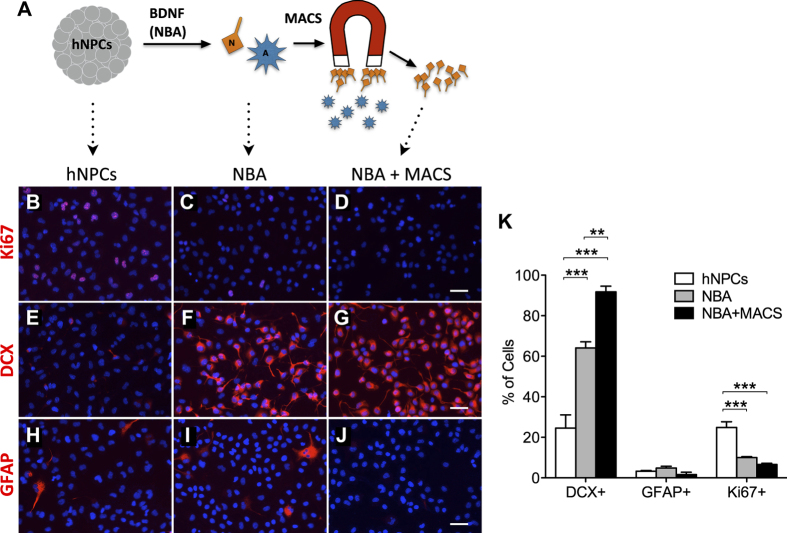
In vitro phenotypes of hNPCs differentiated in the neuroblast assay (NBA), followed by enrichment of the immature neuron subpopulation using MACS.(A) Overall experimental design. hNPC neurospheres were dissociated into single cells and plated in the NBA, generating a mixed population of neurons (N) and astrocytes (A). The neurons were then isolated from the astrocytes via MACS. Lastly, phenotyping was performed on the cells during the three major phases of the experiment. (B–D) Fluorescent images of immunocytochemical staining show hNPCs significantly lose expression of the proliferation marker Ki67 during the NBA. Enrichment of the neuron subgroup after the NBA, using MACS, reduces Ki67 expression still further (scale bar = 20 μm) (49,6-diamidino-2-phenylindole (DAPI), blue). (E–G) hNPCs significantly gain expression of the immature neuron marker DCX during the NBA. Enrichment of the neuron subgroup after the NBA yields an even higher percentage of DCX+ cells (scale bar = 20 μm) (49,6-diamidino-2-phenylindole (DAPI), blue). (H–J) Expression of the astrocyte marker GFAP increases slightly during differentiation, but MACS purification removes virtually all the percentage of GFAP+ cells (scale bar = 20 μm) (49,6-diamidino-2-phenylindole (DAPI), blue). (K) Quantification of immunolabeled cells indicates the differentiation of hNPCs into immature neurons during the NBA, and the subsequent purification of neurons made possible by MACS. Means + s.e.m. *P < 0.05, **P < 0.01, ***P < 0.001, by one-way ANOVA, followed by Bonferroni’s test.